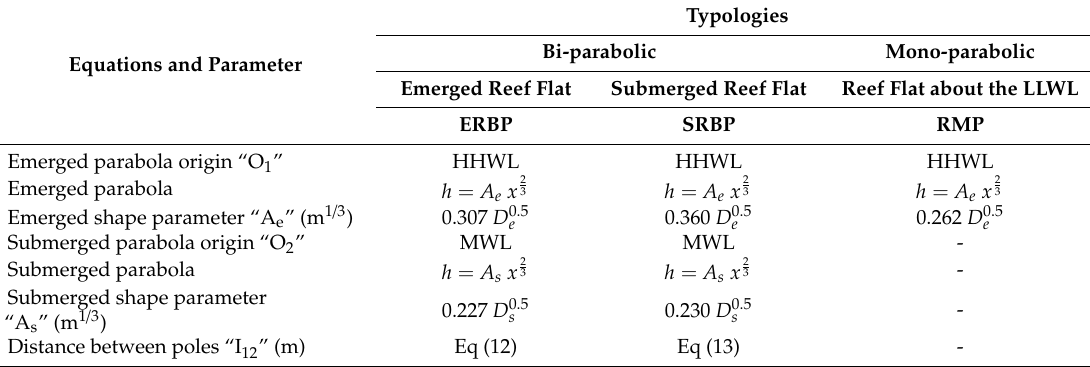
Table 2. Summary of equations and formulae to calculate (for each typology) the parameters used to model nourished